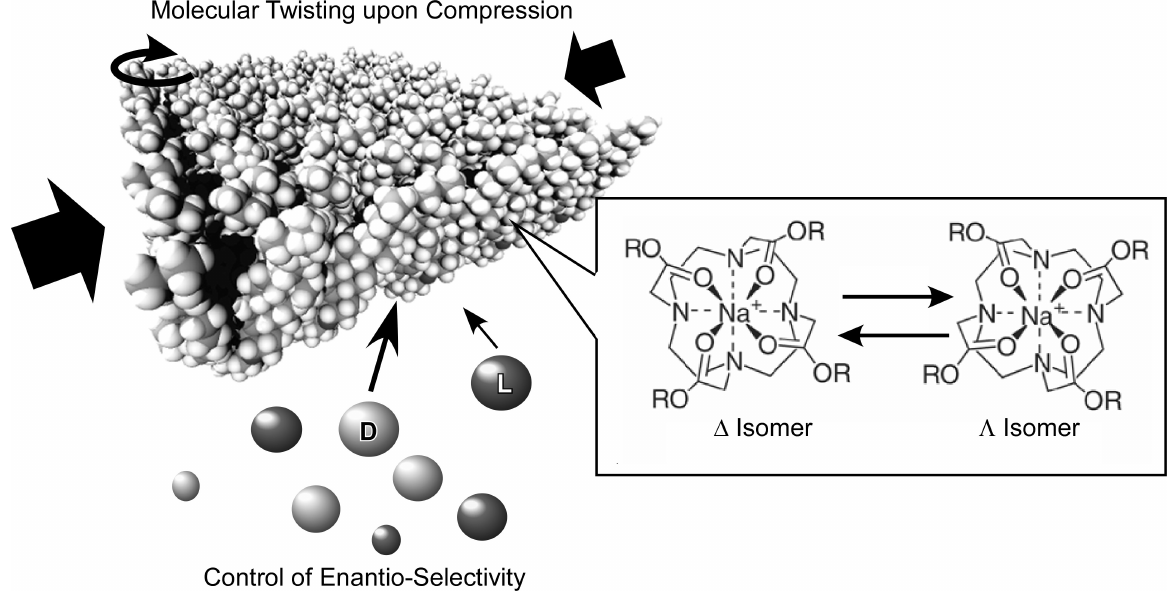
Figure 6. Dynamic chiral recognition of amino acids by polycholesteryl-substituted cyclen complex at the air-water interface. Reprinted with permission from [64] ©2006, American Chemical